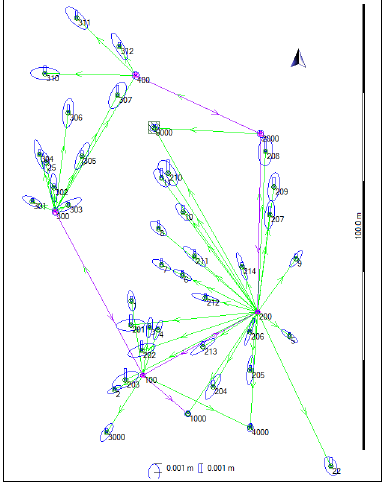
(Fig. 6) photogrammetrically calibrated (Previtali et al., 2013).